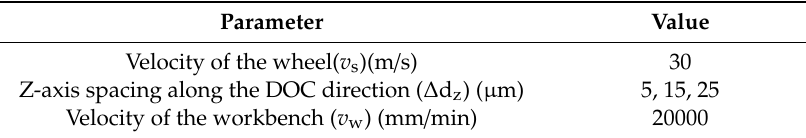
Table 1. Experimental parameters of two grits